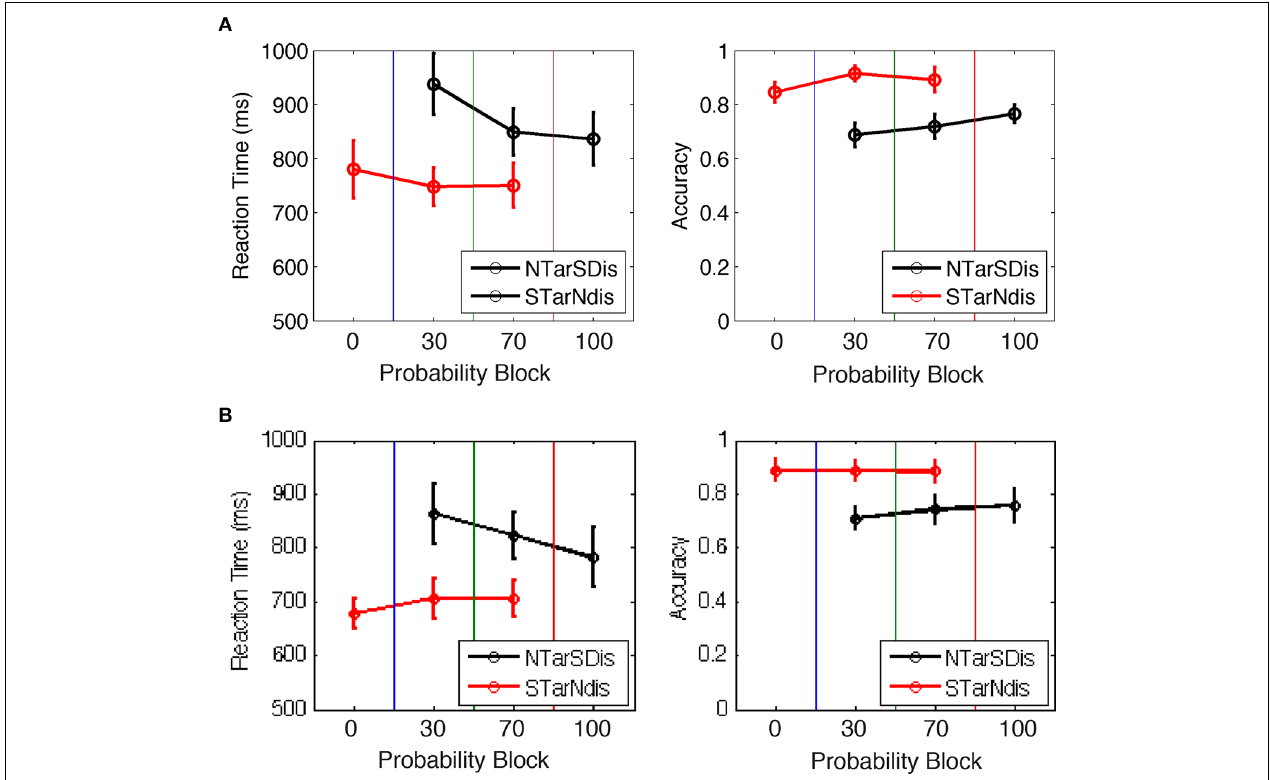
FIGURE 3 | Behavioral performance for Experiments (A) 1A and (B) 1B, showing that RT and accuracy changed with the manipulation of target vs. distractor saliency. NTarSDis, neutral target + salient distractor; NTar, neutral target alone; STarNdis, salient target + neutral distractor; star, salient target alone.